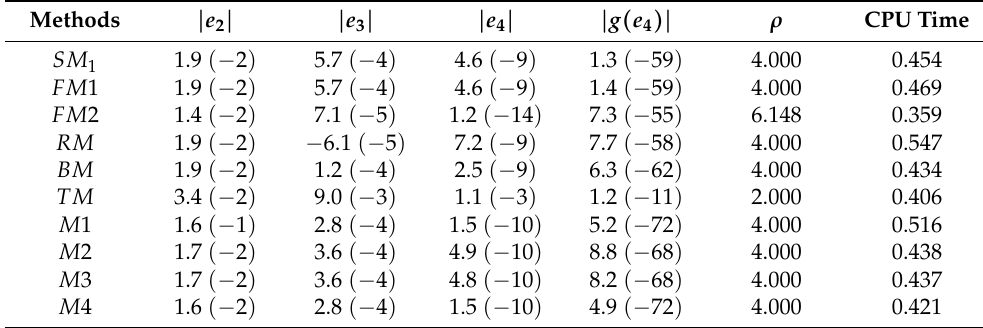
Table 1. The outcomes of Example 1 based on various